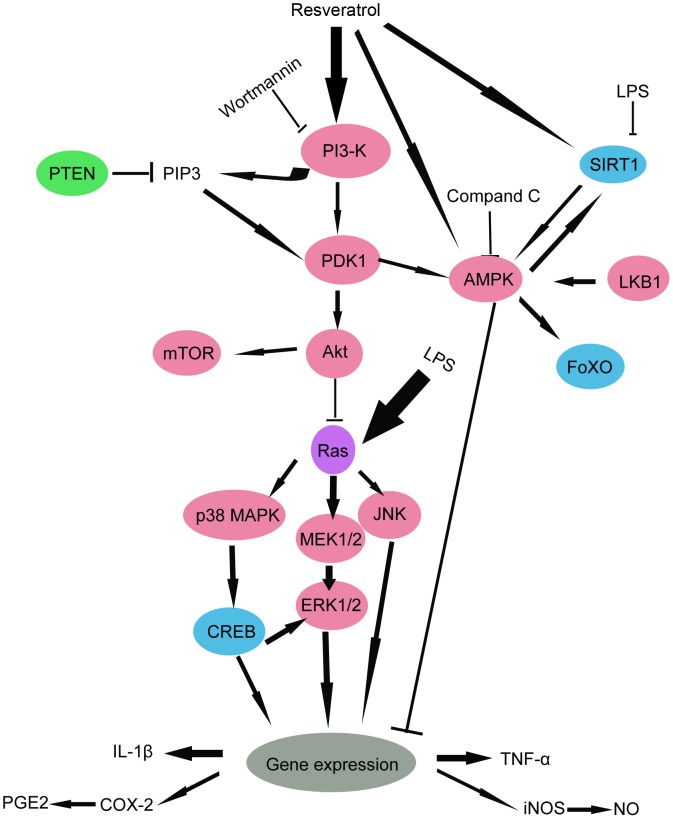
A schematic diagram showing the interlinks of PI3-K signaling pathway.